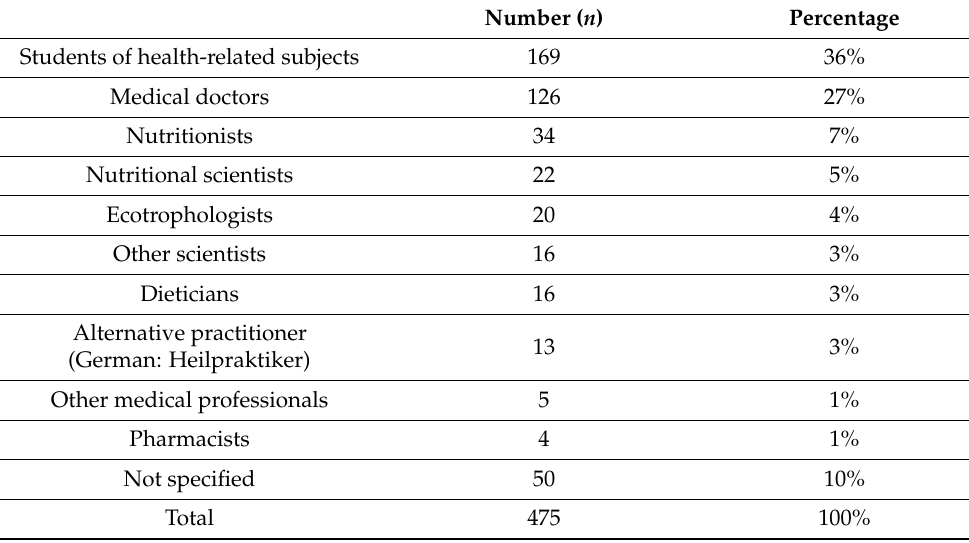
Table 1. Occupational distribution of the study population.